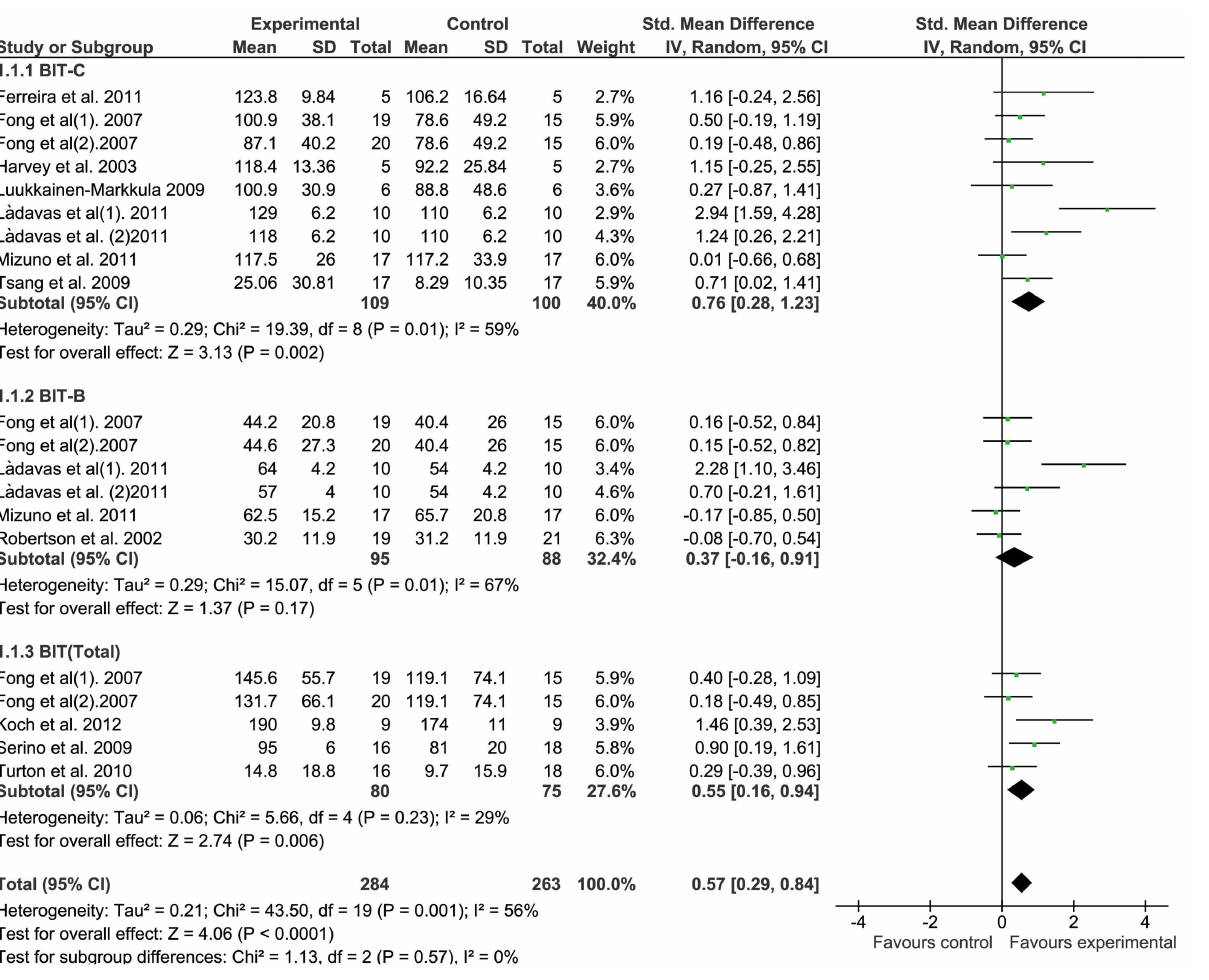
FIGURE 2 | Rehabilitation interventions versus any control, outcome: immediate effects